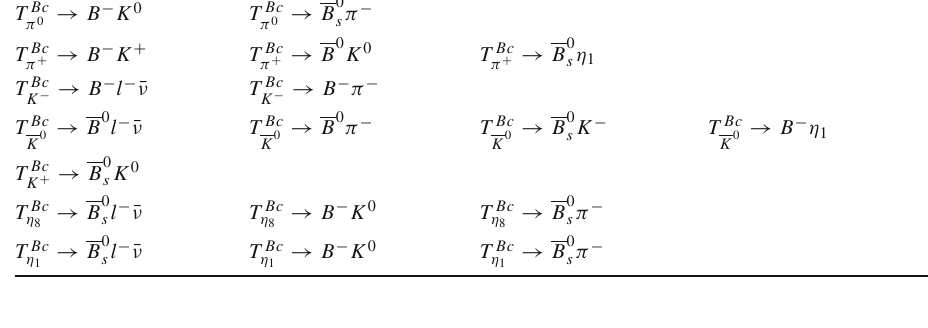
Table 10 Golden channels for T b ¯ c 8 / T b ¯ c 1 b -quark